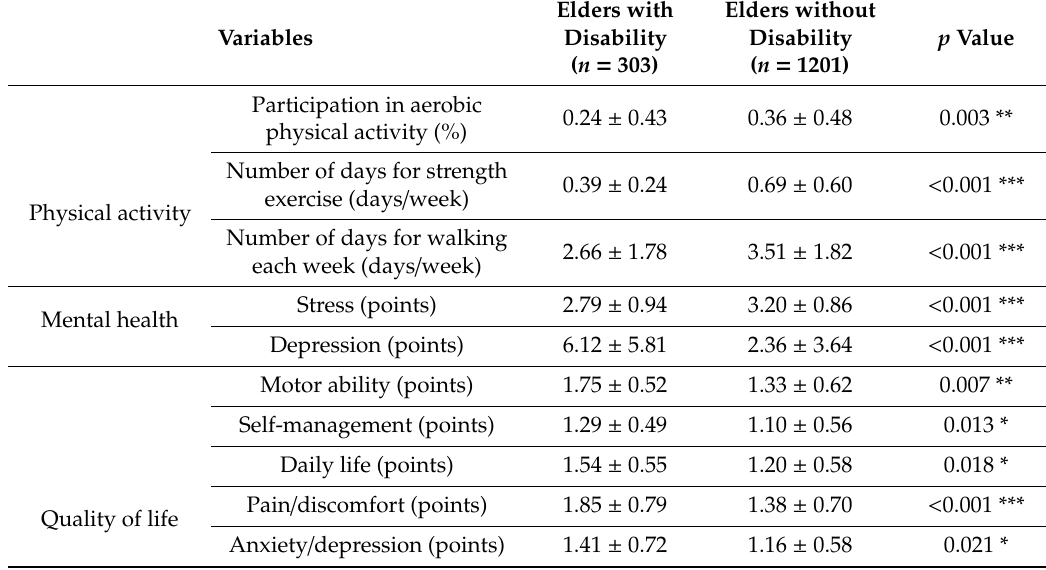
Table 2. Di ff erences in physical activity, mental health, and quality of life in elders with and without disabilities ( n = 1504).